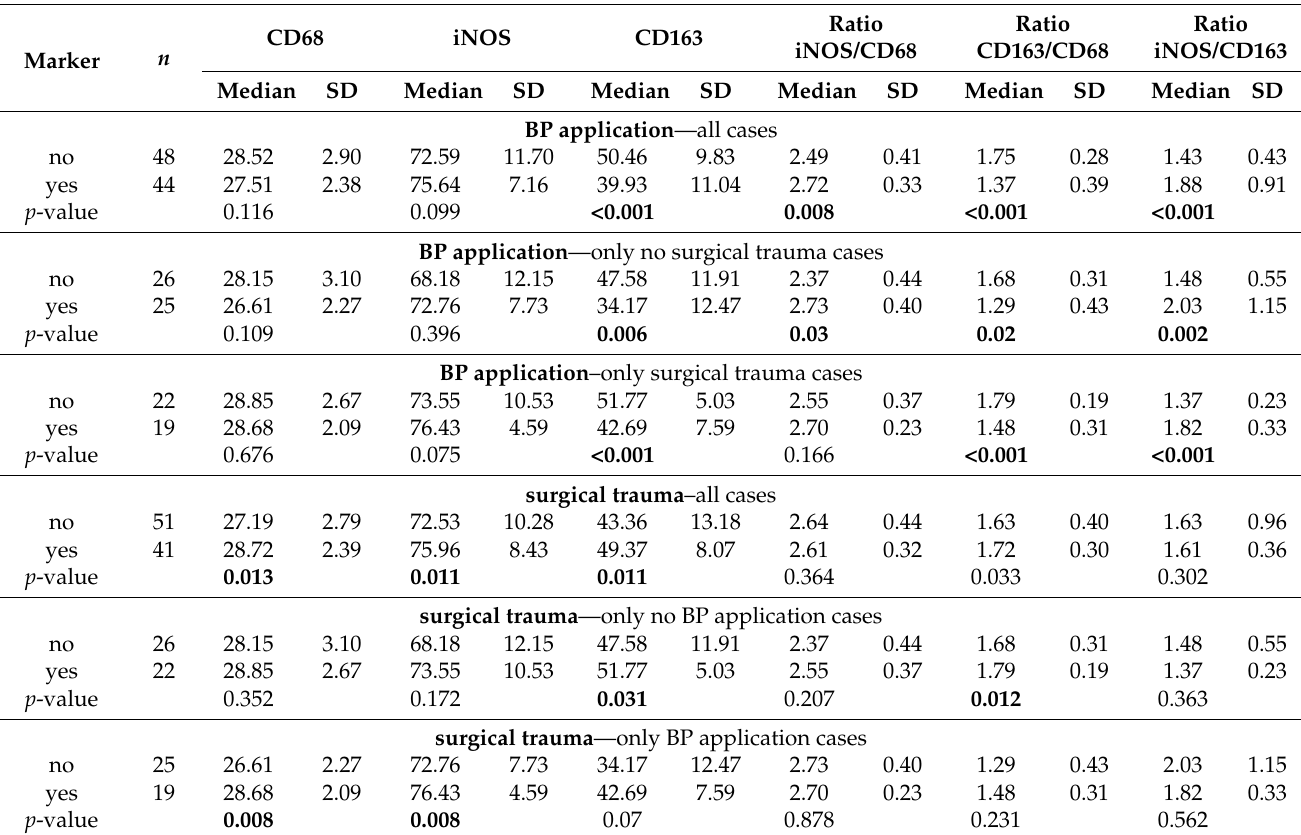
Table 3. CD68. iNOS und CD163 expressions (pos. cells/all cells in %) and iNOS and CD163 to CD68 ratios. p -values were calculated by